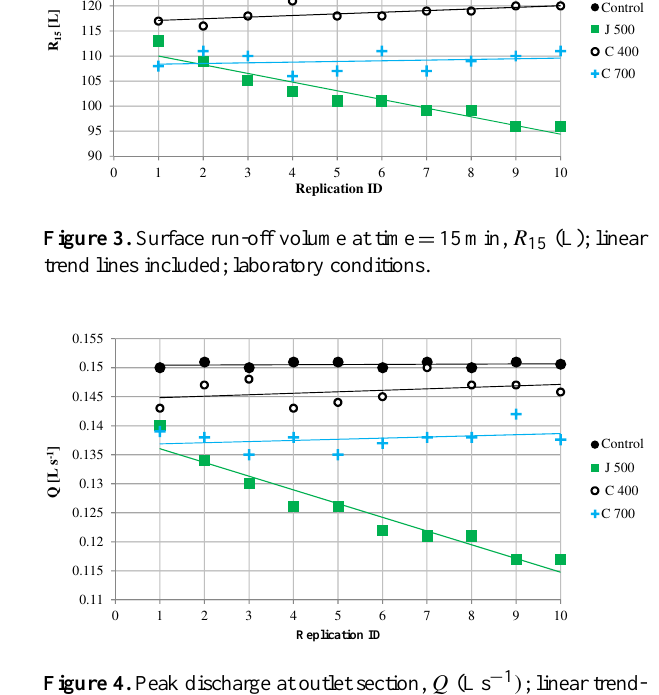
Table 4. Statistical description of peak discharge for 500gm − 2 jute net (J500), 400gm − 2 coir net (C400), and 700gm − 2 coir net (C700) in laboratory experiments.